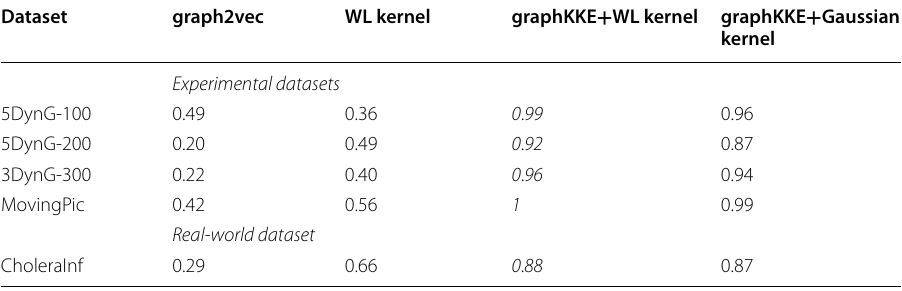
Table 3 Adjusted Rand Index (ARI) for the comparative analysis on the graph clustering task in Sect. 5.3. Higher ARI corresponds to greater accuracy in correctly identifying the ground truth states. It can been seen that the combination of graphKKE with Weisfeiler–Lehman kernel outperforms other